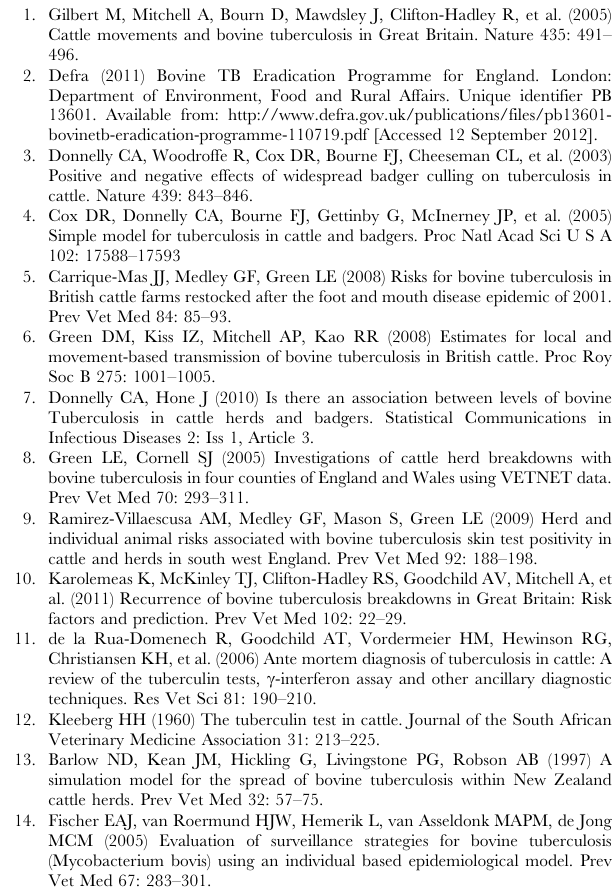
Figure S13 Impact of herd-level interventions on probability of recurrence within 24 months. Change in the probability of a